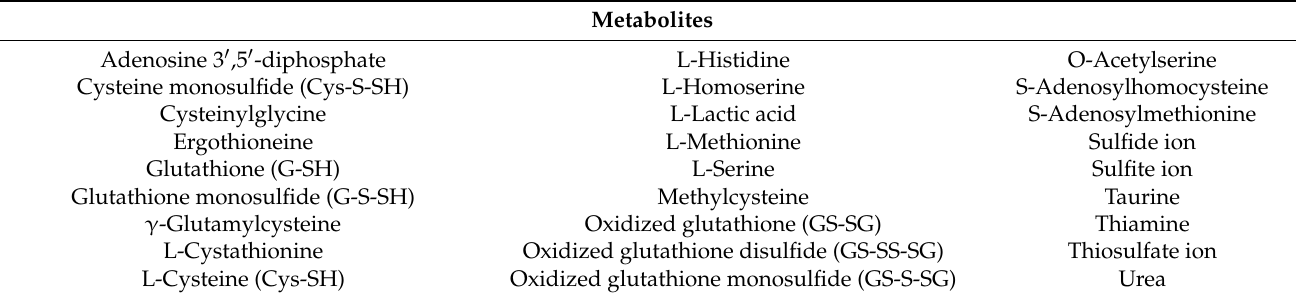
Table 1. List of 27 metabolites detected in the mouse